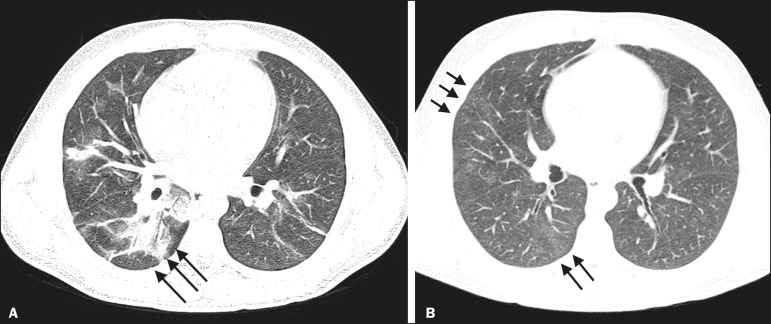
A 29-year-old male patient. A: CT scan acquired on day 4 after symptom onset, showing peribronchovascular consolidations (a stage 3 finding) in the right lower lobe (arrows). B: CT scan acquired on day 14 after symptom onset. The patient still had a mild cough and dyspnea. There are discrete residual ground-glass opacities (a stage 4 finding) in the right lung (arrows).